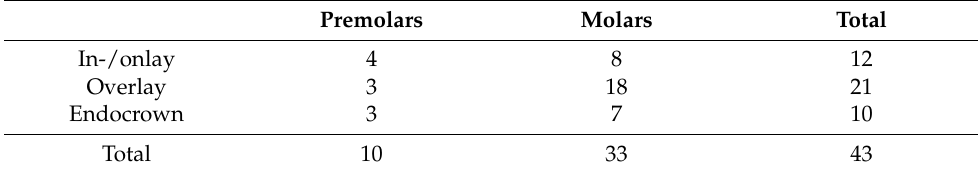
Table 4. Distribution of the involved restoration